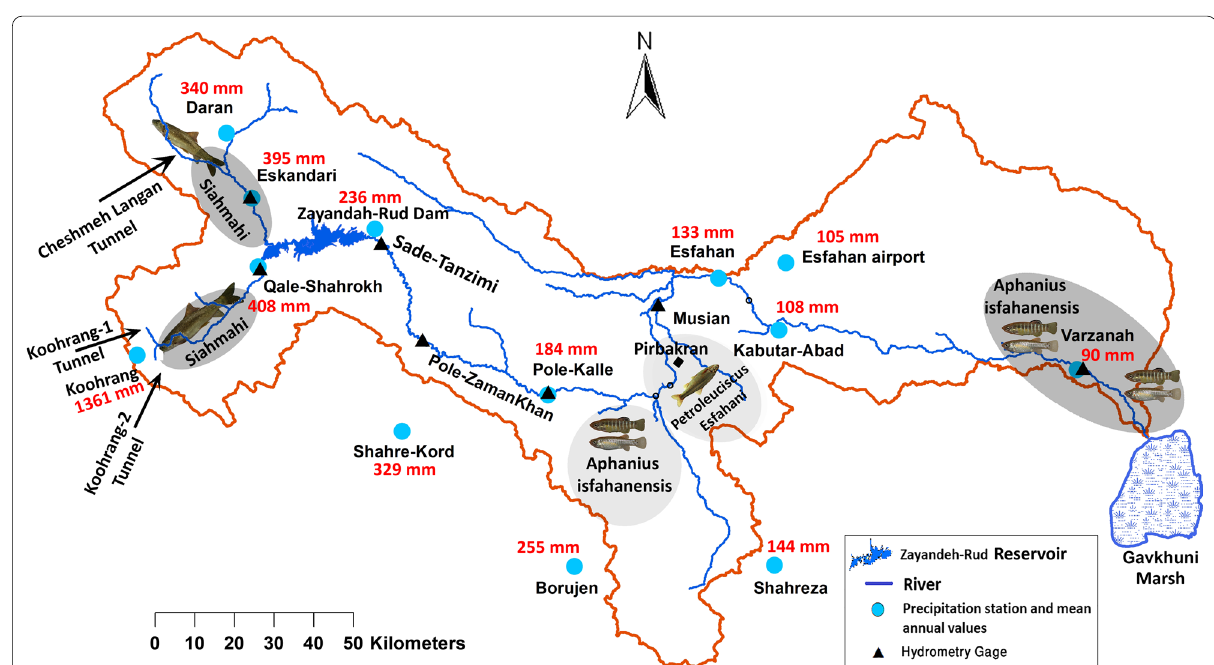
Fig. 1 The study area, main water resources components, mean annual precipitation through the basin (red labels), and the distribution map of the three endemic